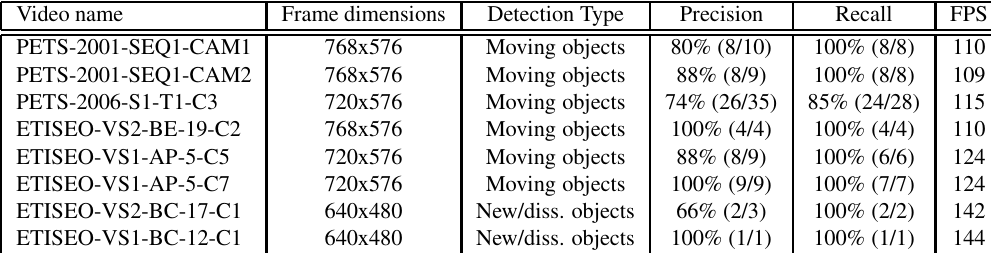
Table 1: Video analysis algorithms testing results